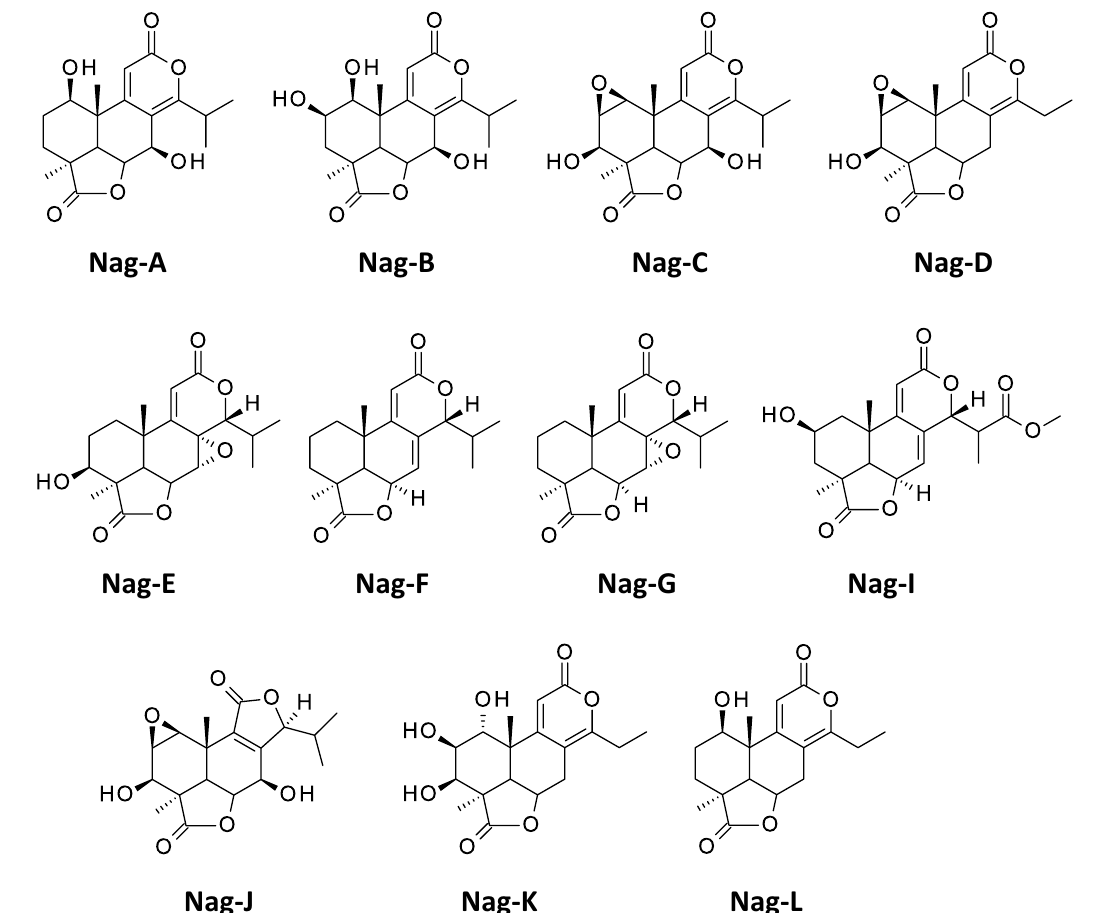
Fig. 1 Chemical structure of the nagilactones. The structure of Nag-H could not be identified